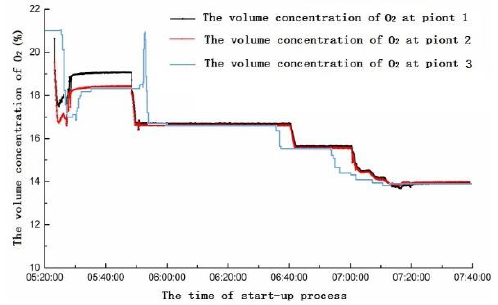
Figure 16. Oxygen concentration at Point 1 and Point 2.